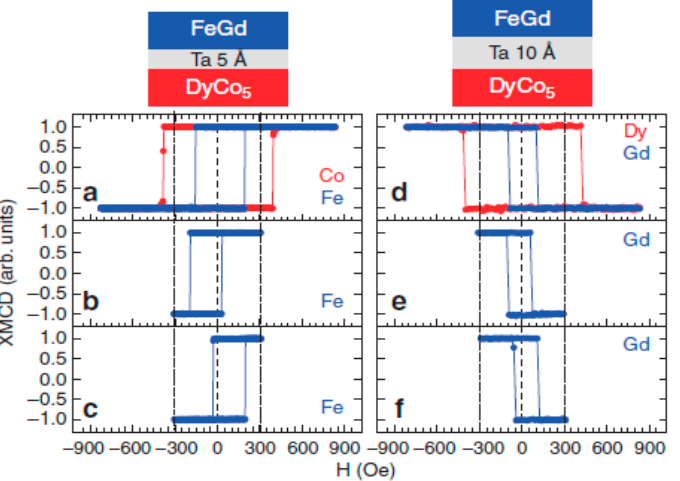
Figure 7. Exchange-biased loops for two representative samples. Left column: hysteresis loops measured for a sample with 0.5 nm Ta spacer: measured from 900 to − 900 Oe ( a ), measured between 300 and − 300 Oe after saturating at 3 kOe ( b ), idem to ( b ) but after saturating at − 3 kOe ( c ). Right column: the same scenario was followed for a sample with a 1 nm Ta spacer ( d – f ). The dotted vertical lines mark the 300 and − 300 Oe fields. Reprinted with permission from ref. [52] 2012 Nature.